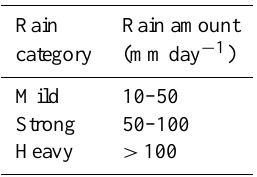
Figure 1. Location of study area and borders (red) of geographi- cal sectors, corresponding to their relative position to the island of Crete. Table 1. The rain categories according to the daily rainfall accumu- lation.